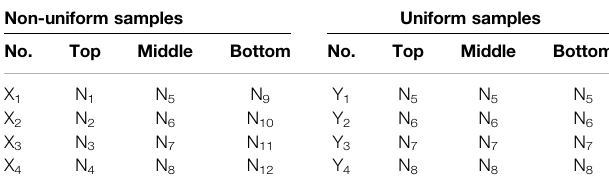
TABLE 1 | Aging time and temperature of disc samples. TABLE 2 | Composition of the non-uniform and the uniform samples.